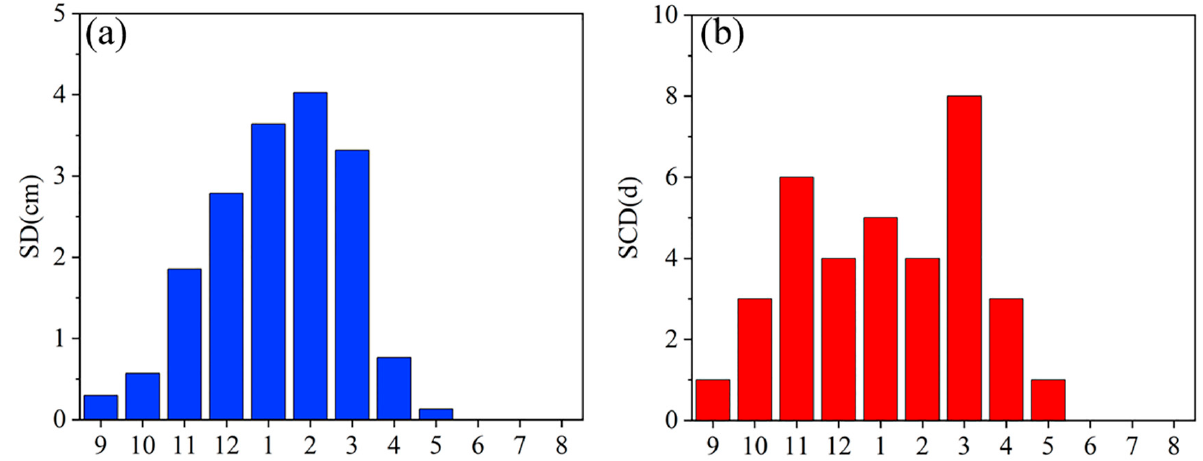
Figure 5. Multiyear averaged monthly distribution of SD ( a ) and SCD ( b ) in SGP (2003–2018).